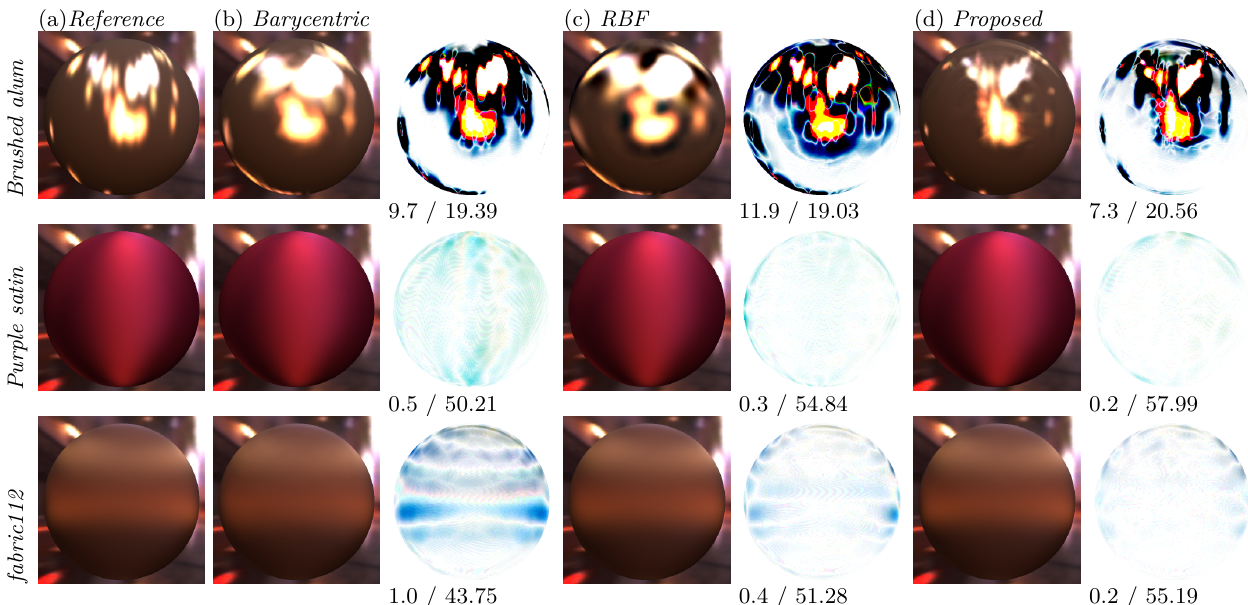
Fig. 10 BRDF rendering on a sphere in the grace environment. The reference BRDF (a) is compared with its reconstruction from 8911 samples using (b) barycentric interpolation, (c) RBF interpolation, and (d) our proposed method. Difference images are scaled 10 × and difference values are given as CIE ∆ E / PSNR (dB).